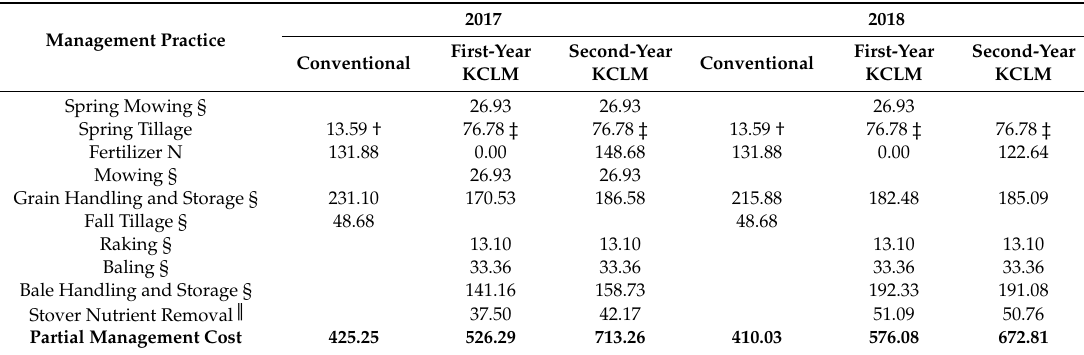
Table 5. Partial management cost (in U.S. $ ha − 1 ) for maize produced conventionally and in KCLM in